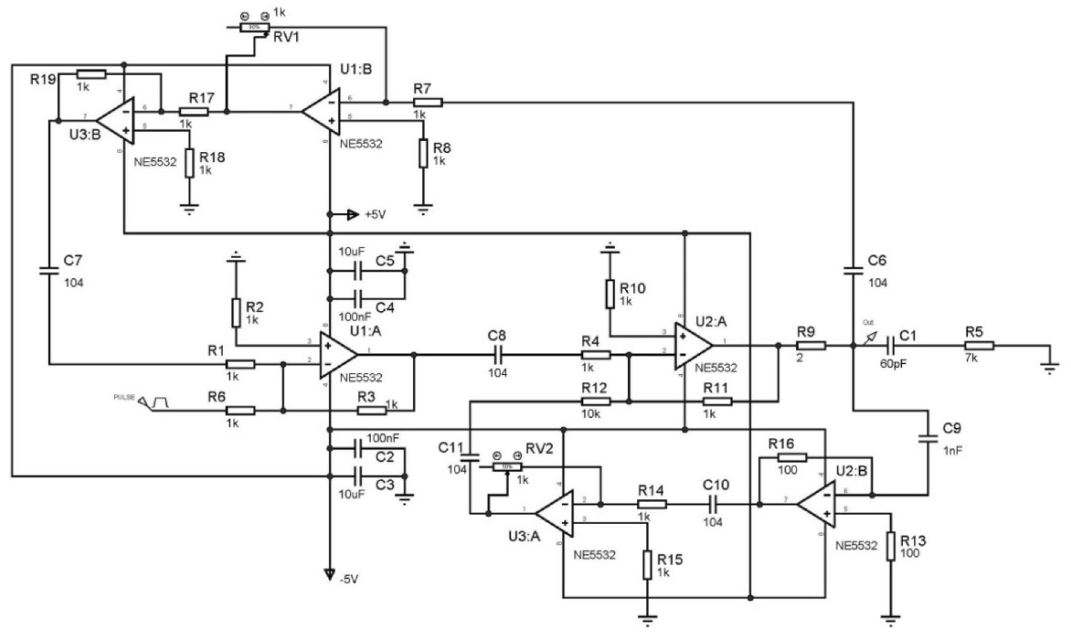
Figure 11. Control circuit for micro electrochemical machining with double feedback